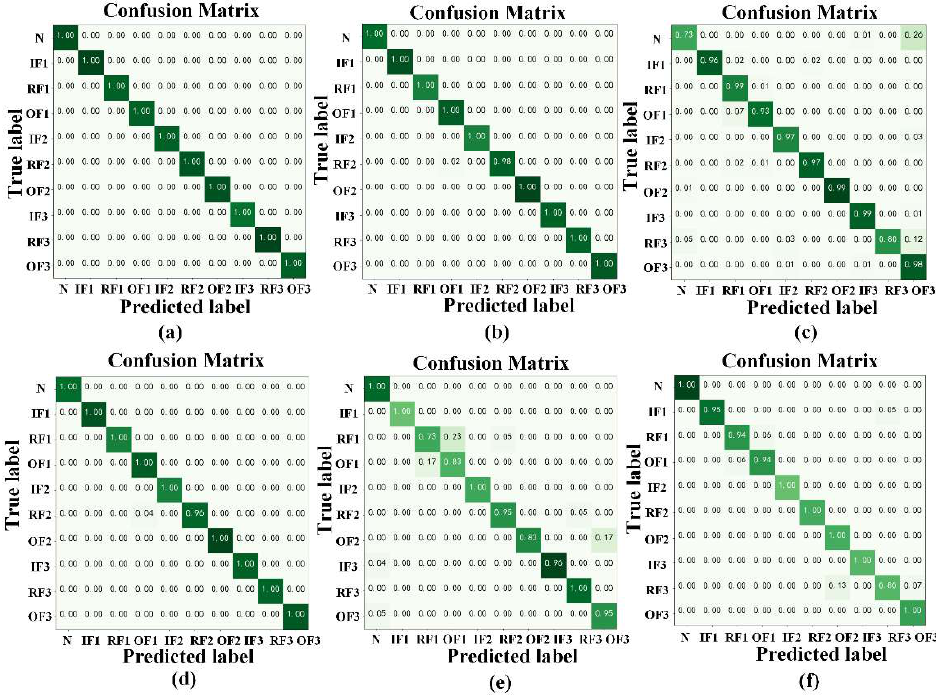
Figure 24. The confusion matrix of different diagnostic results on dataset B, ( a ) The proposed method, ( b ) GAF-SE-CNN, ( c ) GAF-CBAM-CNN, ( d ) GAF-BAM-CNN, ( e ) VMD-Gray image-Resnet50, ( f ) EMD-Gray image-Resnet50.